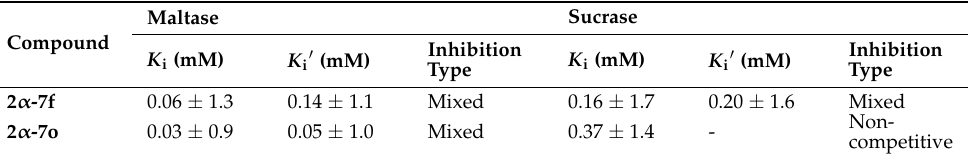
Table 4. Kinetic parameters of 2 α -7f and 2 α -7o on α -glucosidases.